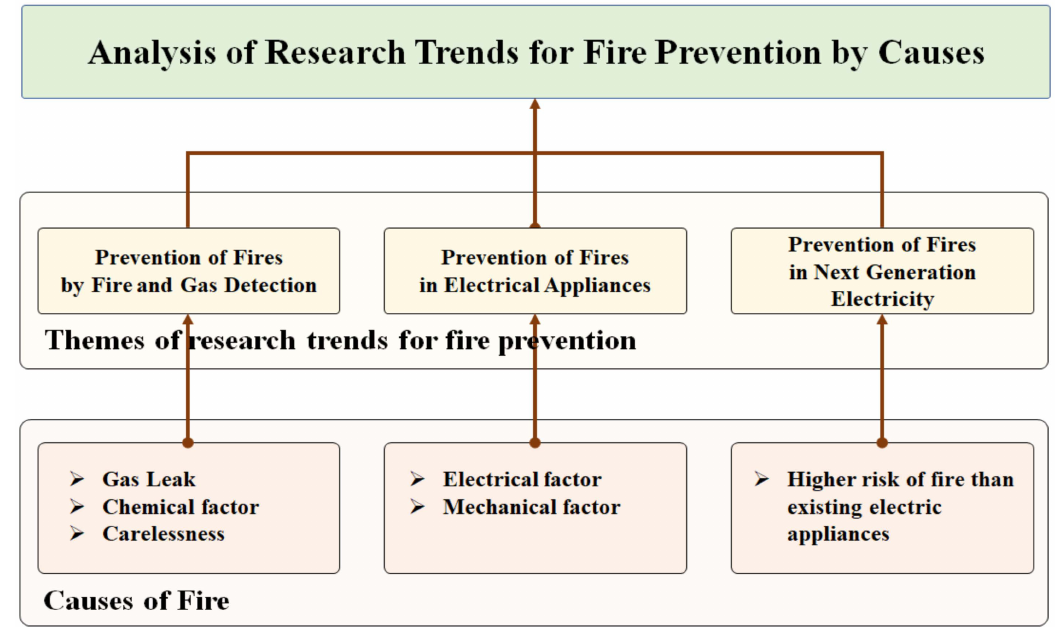
Figure 6. Analysis of research trends for fire prevention by